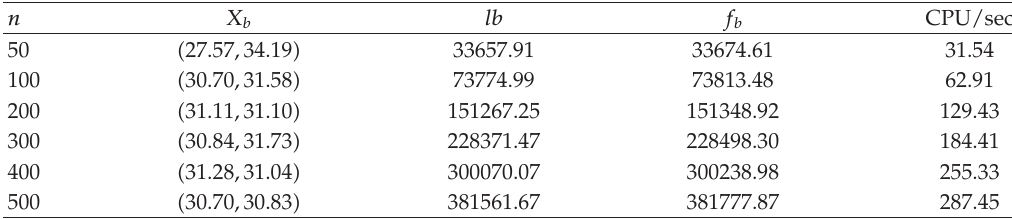
Table 4: The results of Example 4.5.